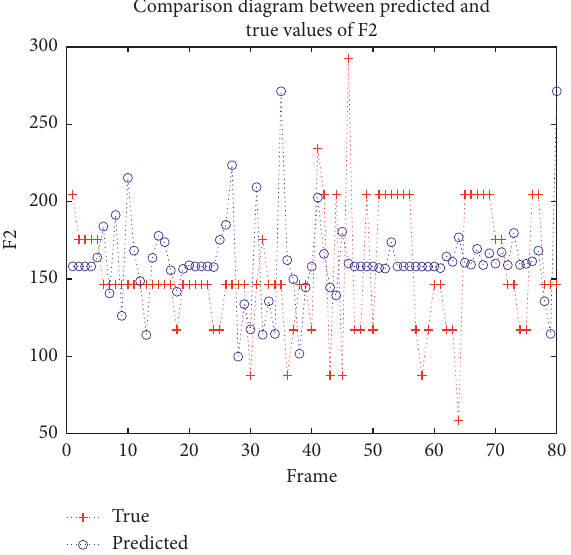
Figure 6: Conversion results of PSO-LSSVM. Table 2: Comparison of RMSE in articulatory-to-acoustic conversion based on GMM, LSSVM, and PSO-LSSVM (Hz). Acoustic feature Emotion